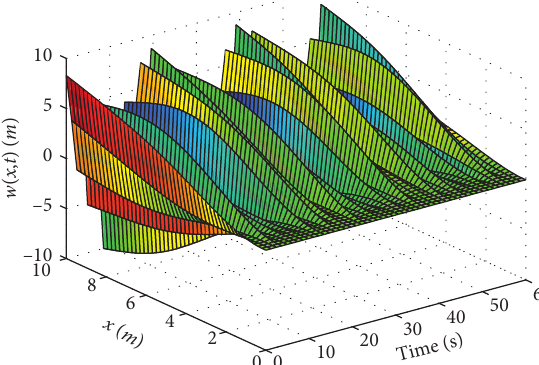
Figure 3: Deflection of the spacecraft without control.